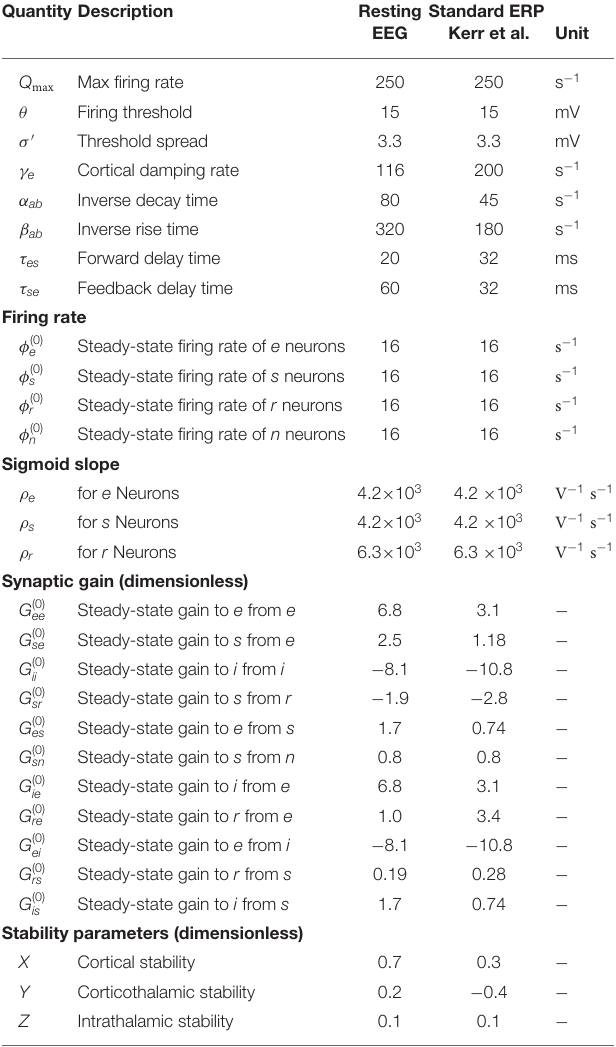
TABLE 1 | Estimated brain parameters for normal adults in the alert eyes-open state. Quantity